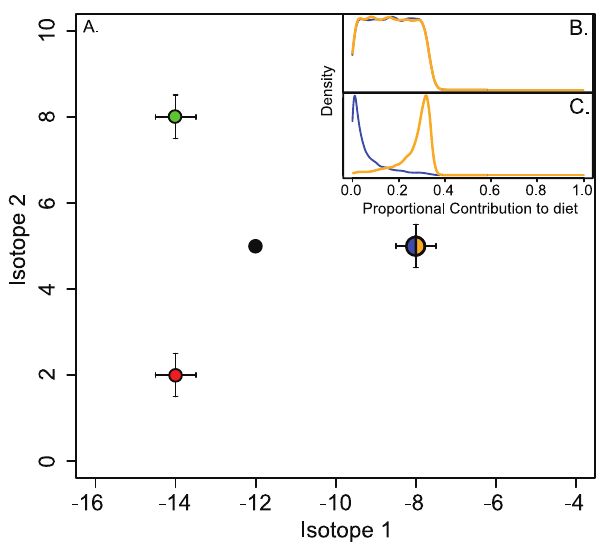
Figure 1. Isotopic niche space of a theoretical single predator, four prey community. A ) The predator (black) and prey (red, green, blue, orange) have a standard deviation of (0.5, 0.5) for both isotope tracer 1 and 2. Two of the four prey (red and green) are isotopically distinct with no overlap. Two of the four prey (blue and orange) are isotopically identical, with w ij =1. B ) Initial MixSIR contribution-to-diet posterior probability distributions for the isotopically identical prey. C ) Final weighted and renormalized posterior probability distributions for the isotopically similar prey. Relative abundance values of 0.9 and 0.1 were applied to the orange and blue prey, respectively.